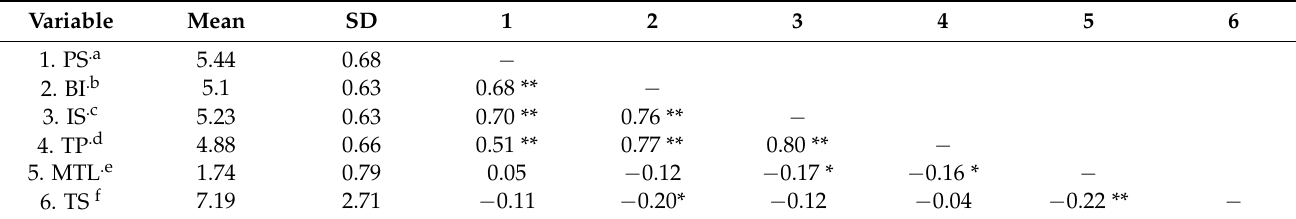
Table 4. Means, standard deviation and bivariate correlations for all variables. n =